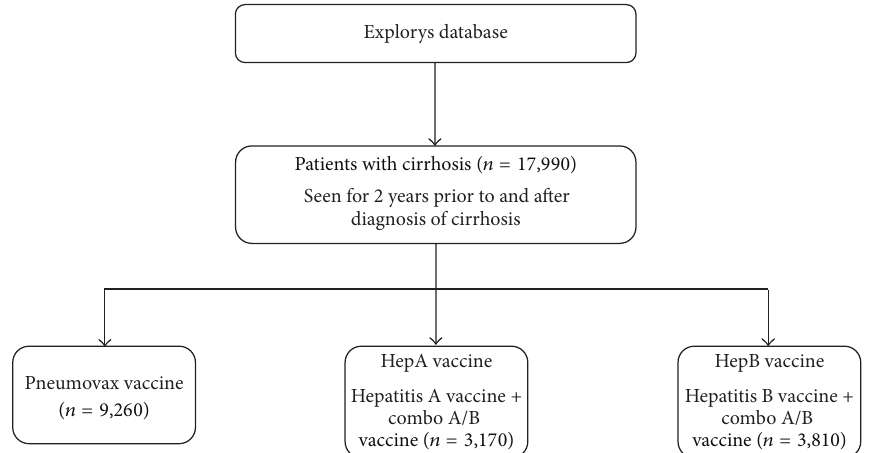
Figure 1: Vaccinations assessed in patients with